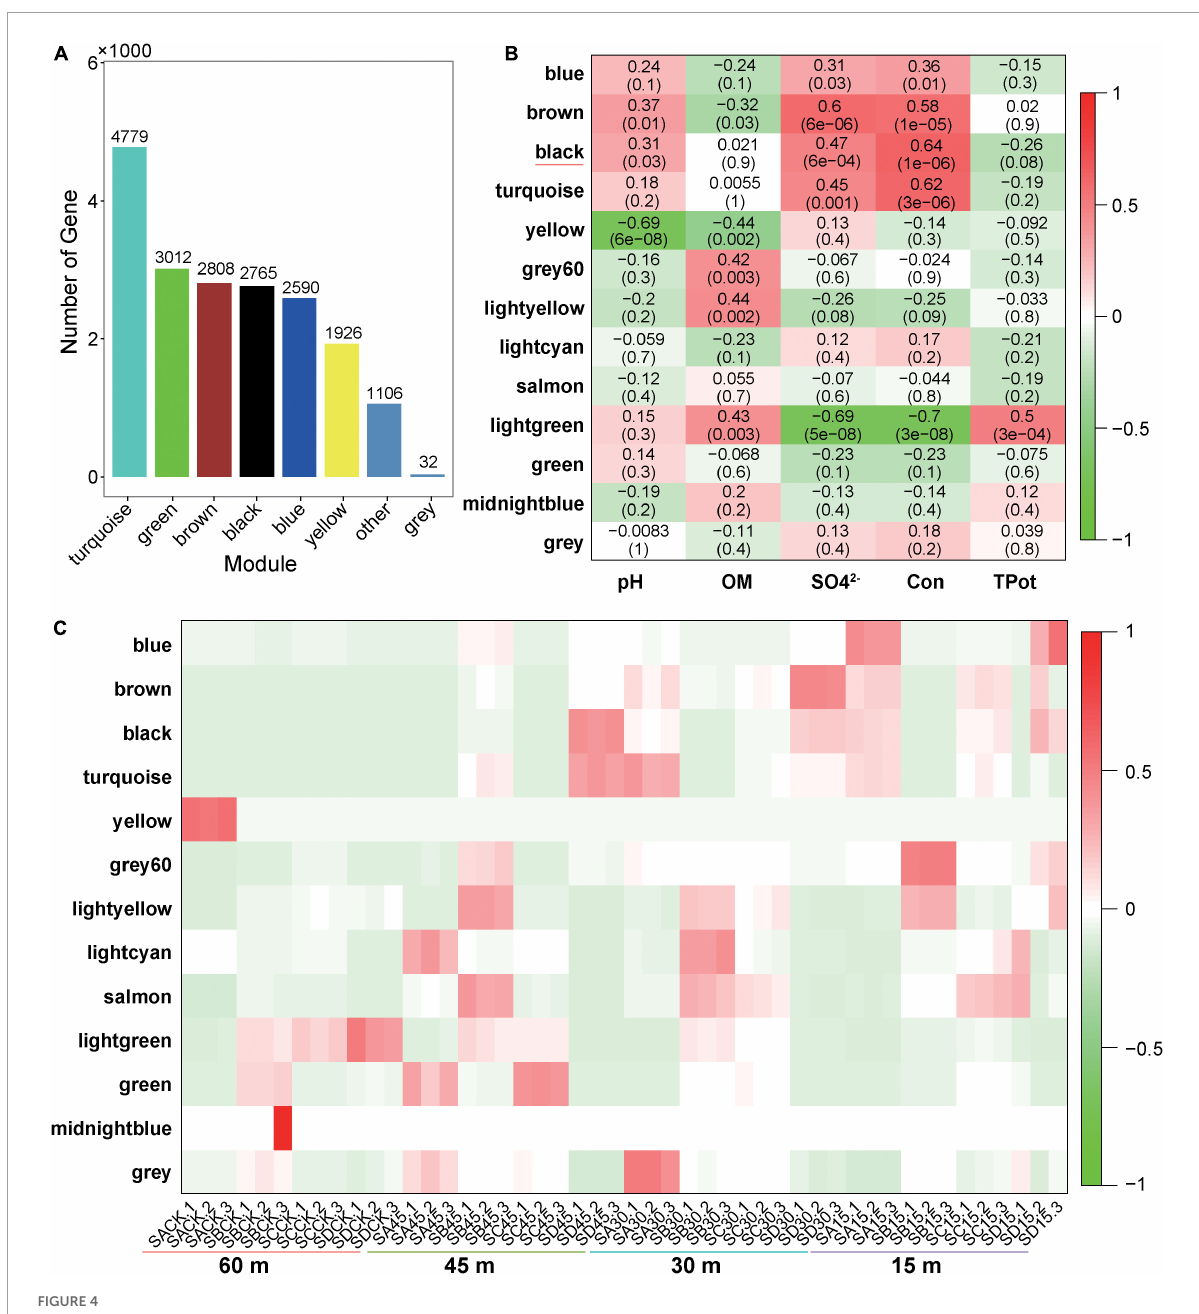
FIGURE4 Correlation analysis of phenotypic traits and screening of key regulatory genes. (A) Represents the number of genes in each module divided based on WGCNA (weighted gene coexpression network analysis); (B) represents the correlation heatmap of the soil phenotype and each module, the leftmost color block represents the module, the rightmost color bar represents the correlation range, and the abscissa is the soil phenotype index. The darker the color in the figure is, the higher the correlation; red indicates a positive correlation, and green indicates a negative correlation. The number in each cell indicates correlation and significance, (C) expression pattern of all modules in the sample.